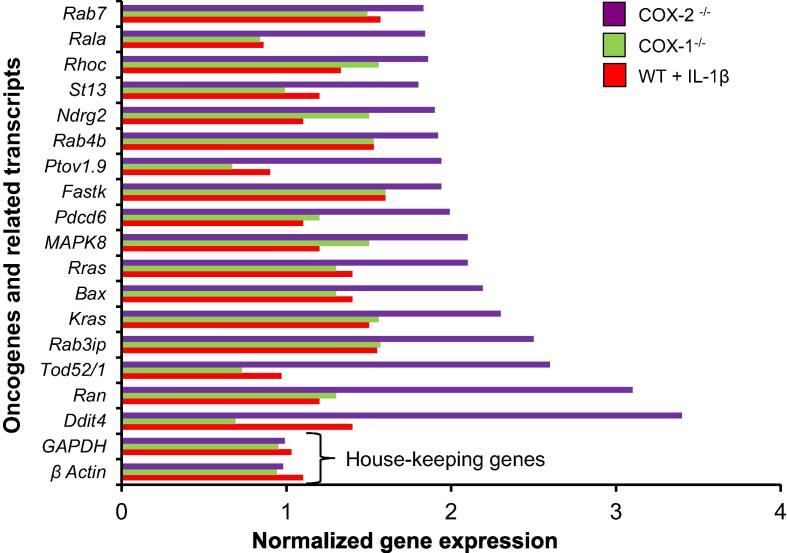
Gene expression array of oncogenes in IL-1β-treated WT, COX-1−/−, and COX-2−/− cellsGene expression arrays of (WT), IL-1β stimulated WT(WT + IL-1β), COX-1−/−, and COX-2−/− cells were executed as previously reported [10]. The graph shows the differential expression of oncogenes and related transcripts. The mRNA expression levels were plotted in arbitrary units as a ratio of WT, after normalizing with the expression levels of housekeeping genes actin and GAPDH. The full forms of the abbreviated gene names are available on http://www.genecards.org/